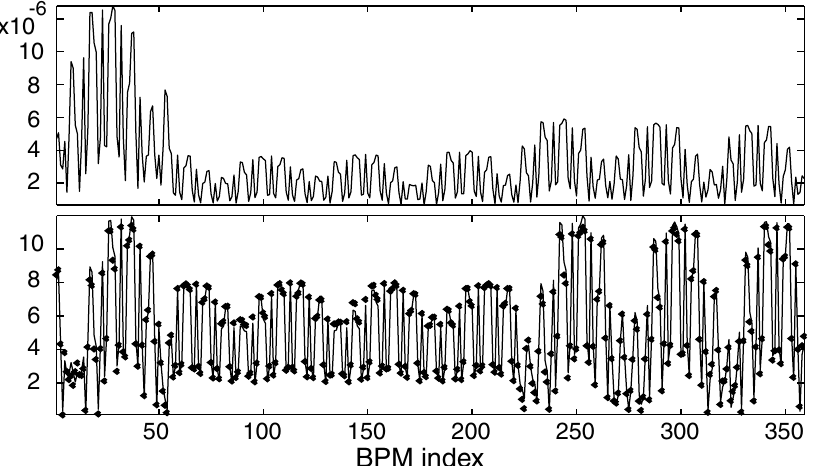
FIG. 3. Amplitudes of the spatial coupling vectors before (top) and after (bottom) the rotation. Dots are the scaled lattice function p (cid:2)(cid:2)(cid:2)(cid:2)(cid:2)(cid:2) (cid:19) c . a b